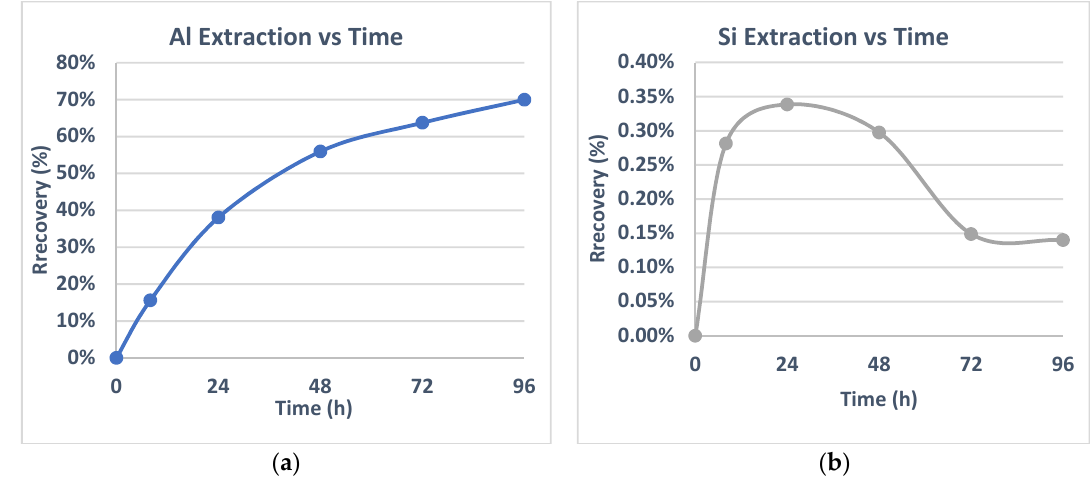
Figure 5. Effect of chemical intensification on the extraction of ( a ) Al, and ( b ) Si values from AMB Kaolin (stirring rate: 300 rpm, HCl concentration: 5.89 M, temperature: 90 °C, retention time: 96 h).